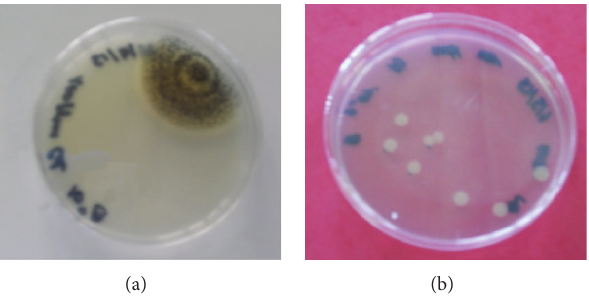
No growth Negligible Figure 9: Comparison of growth of Aspergillus niger inoculated on potato dextrose agar plates after batch incubation of 10 days in (a) blank medium (normal growth) and (b) medium containing 100 ppm Cd(II) (0.9